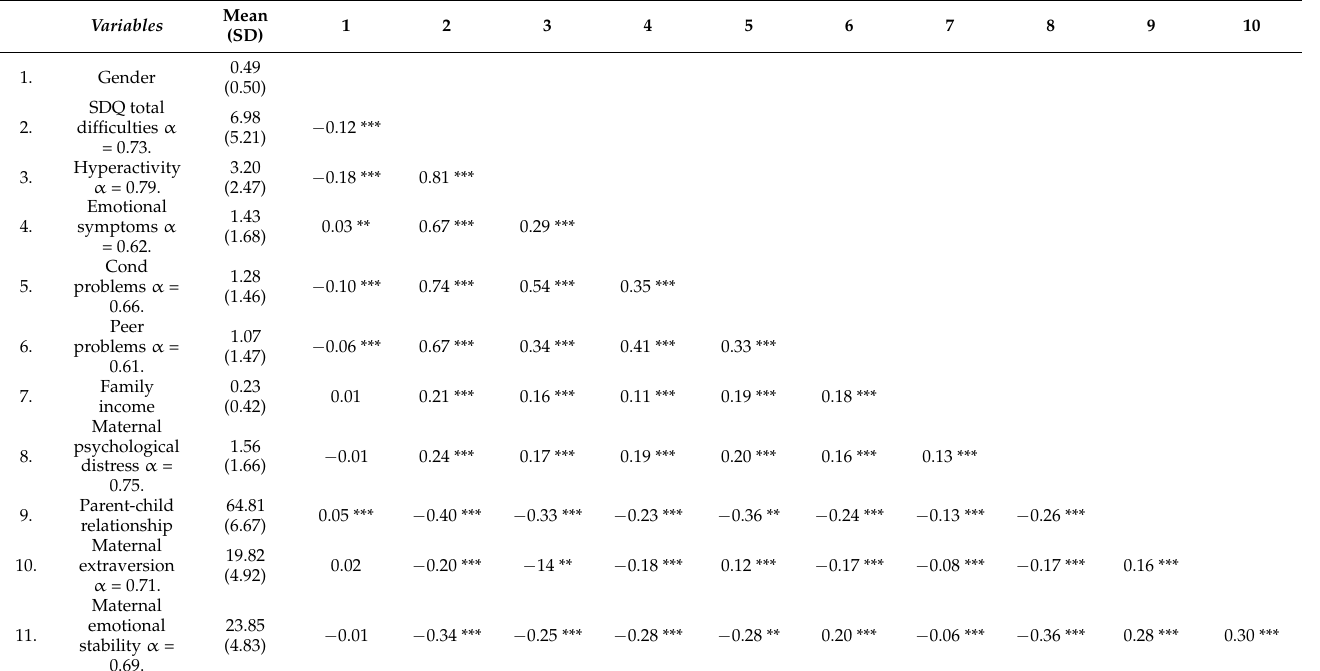
Table 1. Pearson product-moment correlations of SDQ and other variables in the study.